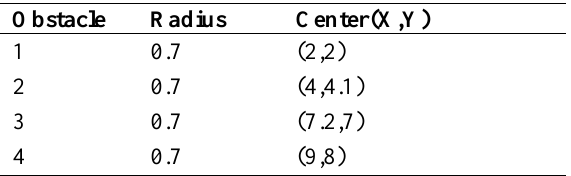
Obstacles definition for case